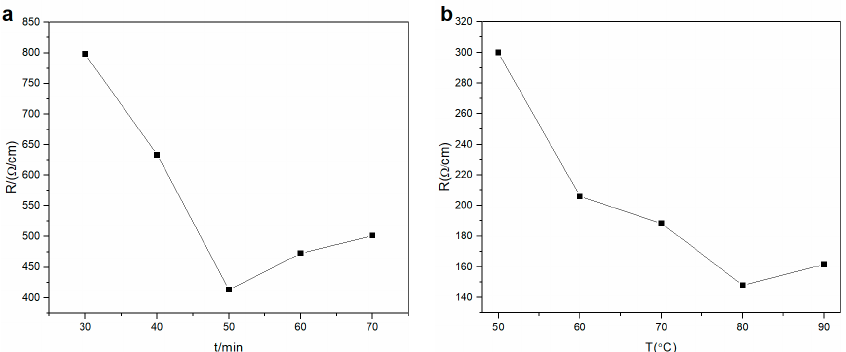
Figure 1. Effect of ( a ) reaction time of reduction agent (50 ◦ C, 40 g · L − 1 ) and ( b ) reduction temperature (concentration = 40 g · L − 1 ; reduction time = 50 min) on electrical surface resistance of the rGO membrane.